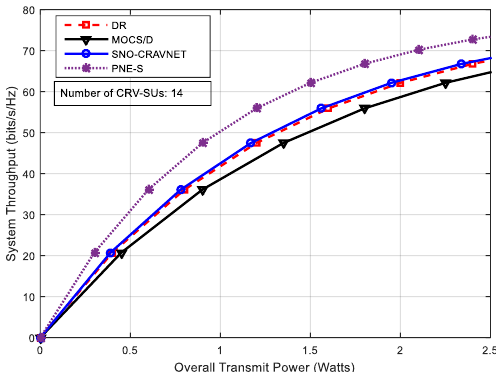
Figure 4. Performance evaluation using the achieved system throughput measured against the overall supplied transmit power with number of Cognitive Radio vehicular secondary users (CRV- SUs) = 14.